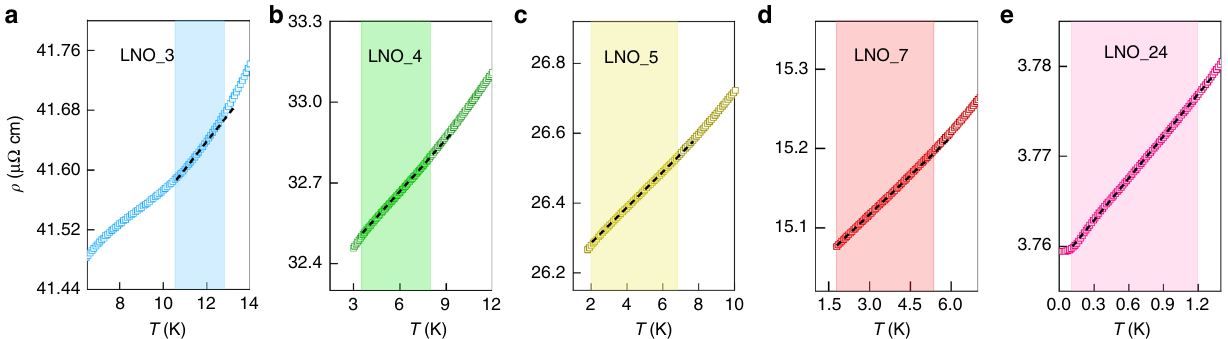
Fig. 3 Resistivity of samples with different disorder levels. a – e Low-temperature measurement of resistivity on samples with different impurity levels. The shaded region in the plot indicates the temperature range where the resistivity shows a linear temperature dependence (quasilinear for low-RRR samples). The black dashed lines are straight guidelines. A downward curvature in the resistivity is observed in these samples near the low-temperature end T ≤ T low the Rosch ’ s model 23 where T low ~ 1 ∕ k F l and T (see Supplementary Note 2).